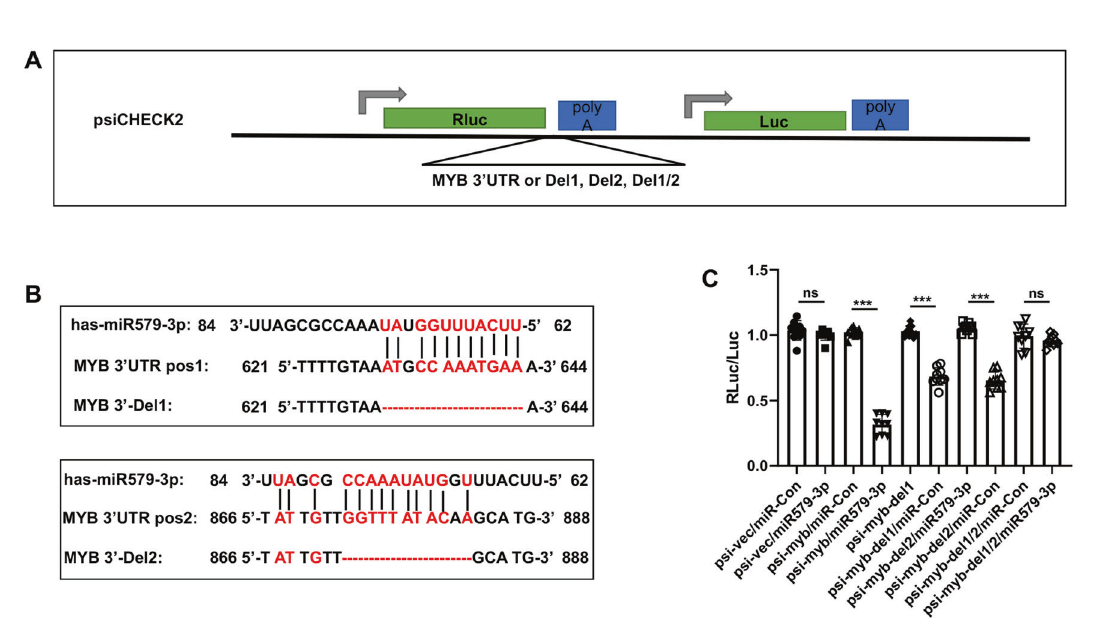
Fig. 4 miR579-3p directly targets the c-MYB mRNA 3 ′ UTR. The cDNA of wild-type 3 ′ -UTR of c-MYB was cloned from the human genome. The sequences of wild type and mutants with 12 bp deletion at position 1, 11 bp deletion at position 2, or deletion of both were ampli fi ed and subcloned into the XhoI and NotI sites between Renilla gene and polyA of the psiCheck2 vector. Each constructed luciferase reporter plasmid or empty vector was transfected into AoSMCs (5000 cells per well) in 96-well plates. Luciferase was assayed at 48 h post transfection using the Dual-Luciferase Reporter Assay System. Luminescence was quantitated and renilla luciferase readings were normalized against the fi re fl y luciferase activity to determine the relative luciferase activity. Data are presented as mean ± SD ( n = 8 replicates). Pairwise comparison was made through Student ’ s t -test: *** P < 0.001; n.s. not signi fi cant. A Schematic of the luciferase reporter vector and constructs. B The miR579-3p sequences complementary to that at positions 1 and 2 of c-MYB 3 ′ UTR. C Relative luciferase activity compared between miR579-3p and